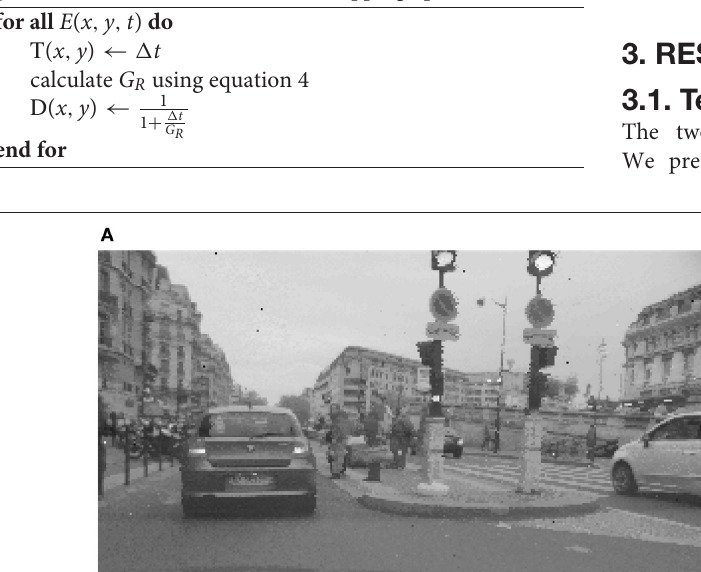
Frontiers in Neuroscience |